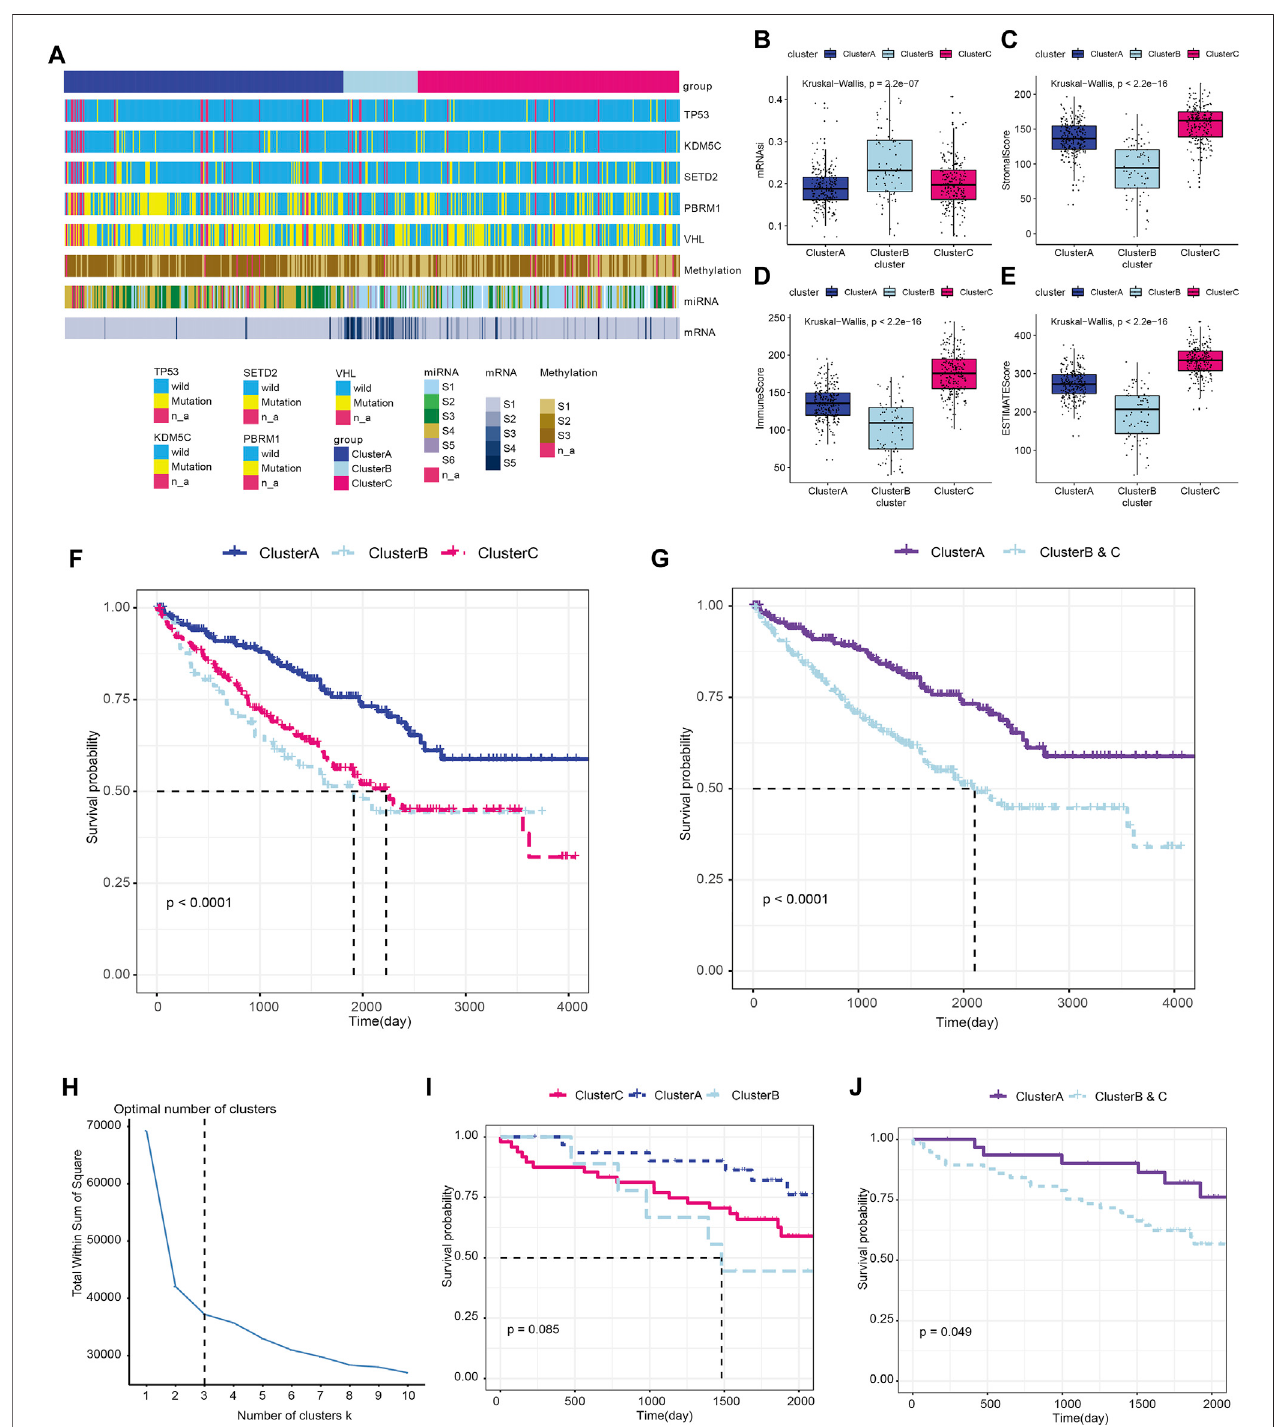
FIGURE 3 | Immune clusters predict tumor heterogeneity and outcomes of ccRCC in training and testing cohorts. (A) Association between the immune clusters and tumor heterogeneity in genetic and epigenetic levels. (B – E) The myeloid in fi ltration score (StromalScore), immune score (ImmuneScore), tumor purity (ESTIMATEScore), and stemness index score (mRNAsi) based on RNA expression data from the TCGA database were measured among subgroups using the Kruskal – Wallistest. (F) PrognosiswascomparedinthethreeimmunesubgroupsintheTCGA-ccRCCcohort. (G) PrognosiswascomparedbetweenClusterAand the newly de fi ned Clusters B and C in the training cohort. (H – J) Prognostic value of the immune clusters in 91 ccRCC patients from the ICGC testing cohort.